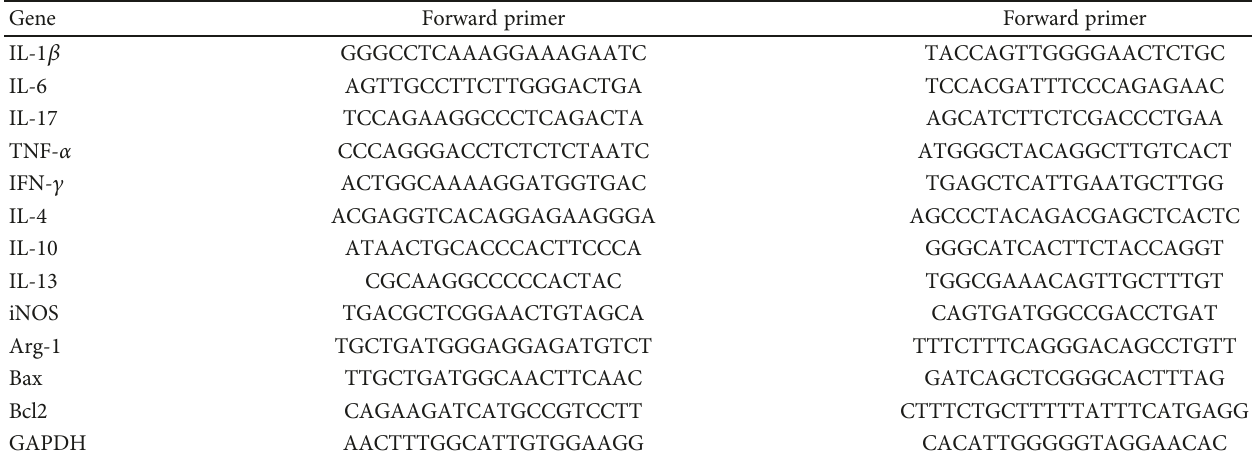
Table 1: RT-PCR primers